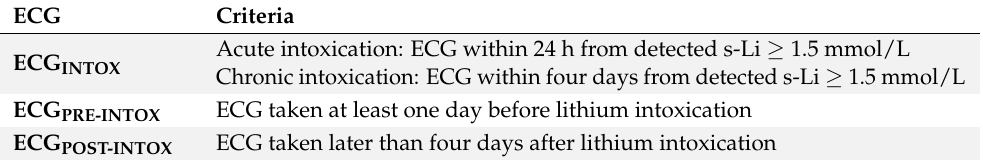
Table 1. Selection criteria for ECG.